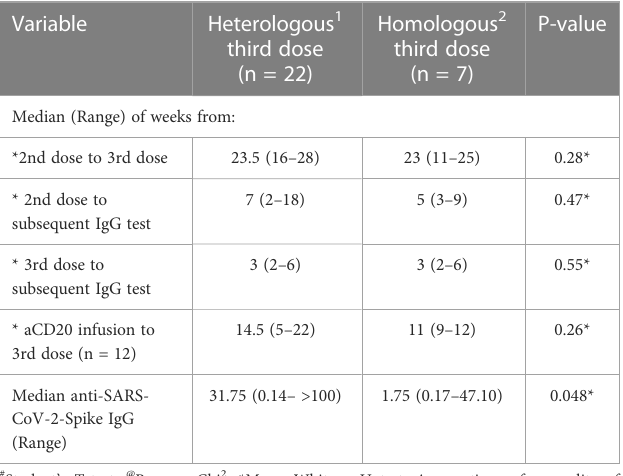
2 Wilcoxon matched-pairs signed rank